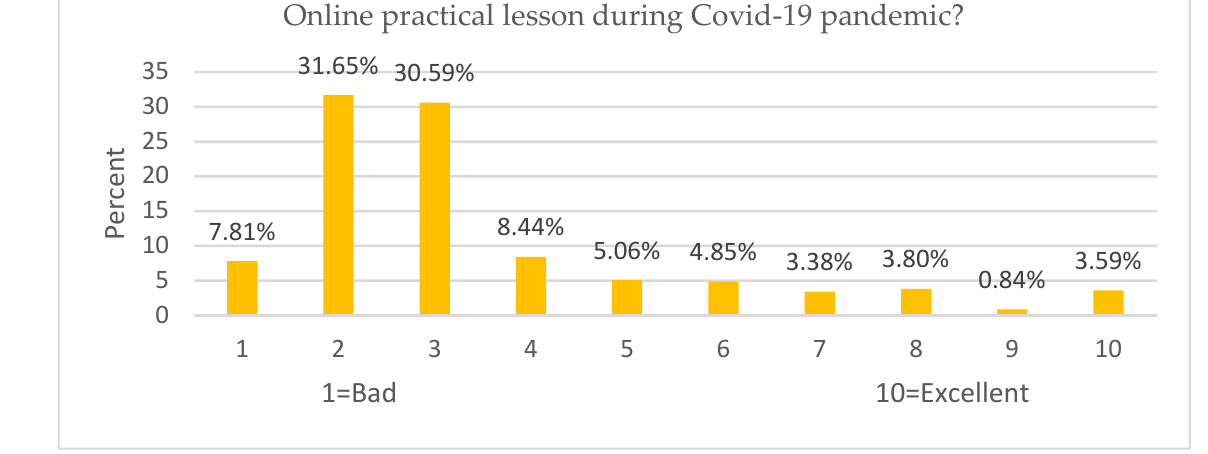
Figure 5. Evaluation of online course contents during lockdown.